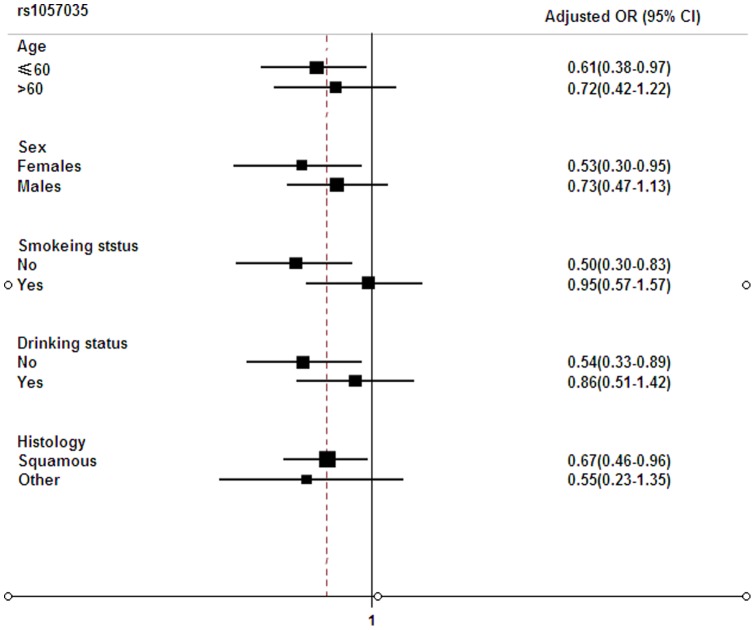
Stratified analyses on associations between variant genotypes of rs1057035 and oral cancer risk (Dominant model).